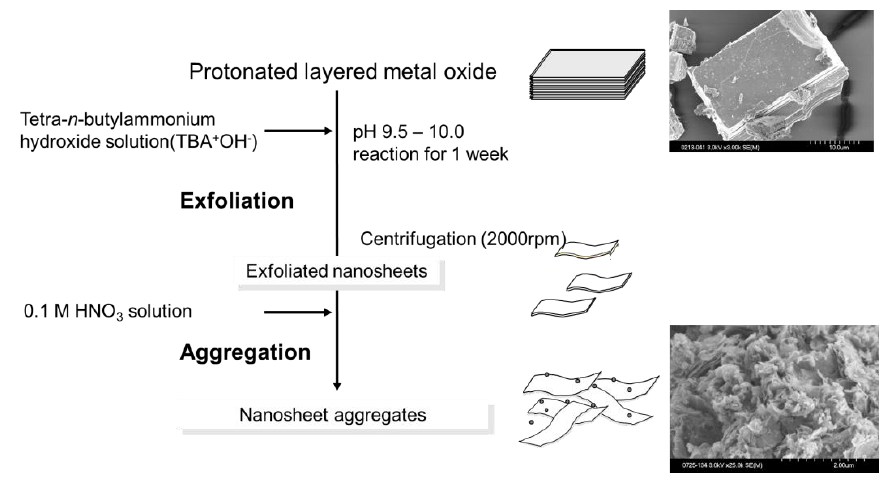
Figure 9. The preparation procedure of metal oxide nanosheet aggregates.